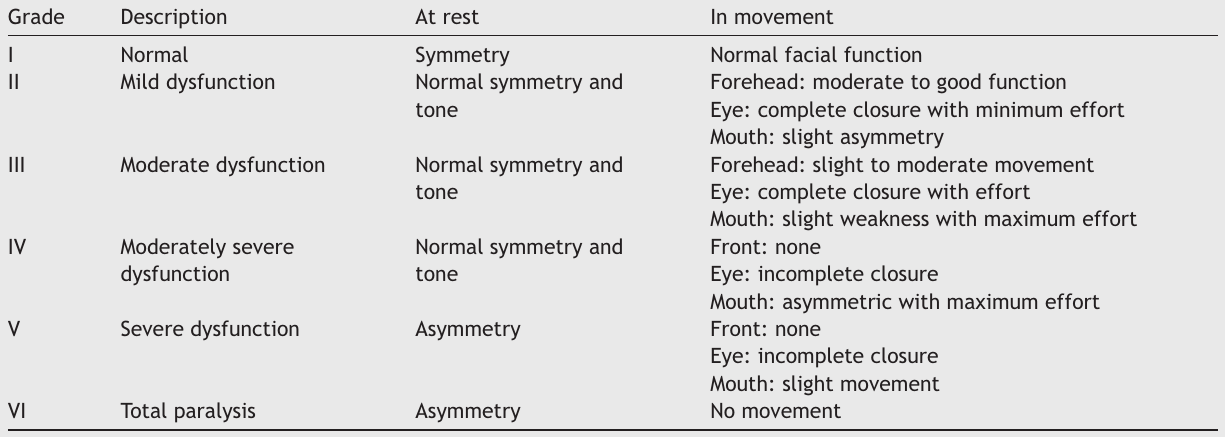
Assessment of facial movement according to House & Brackmann